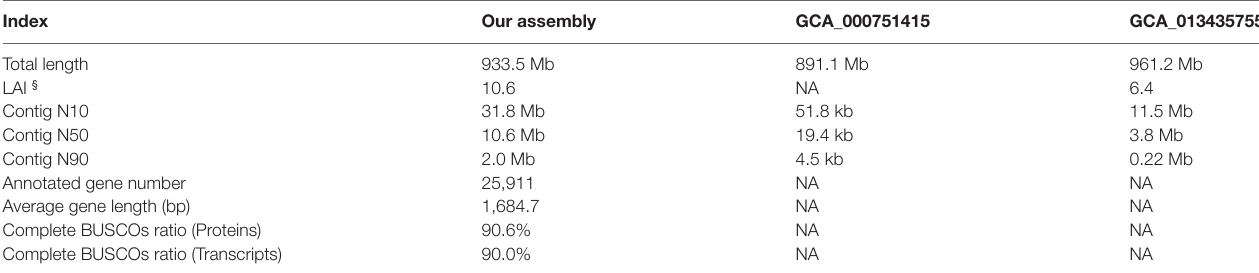
TABLE 1 | Statistics and comparisons of different genome